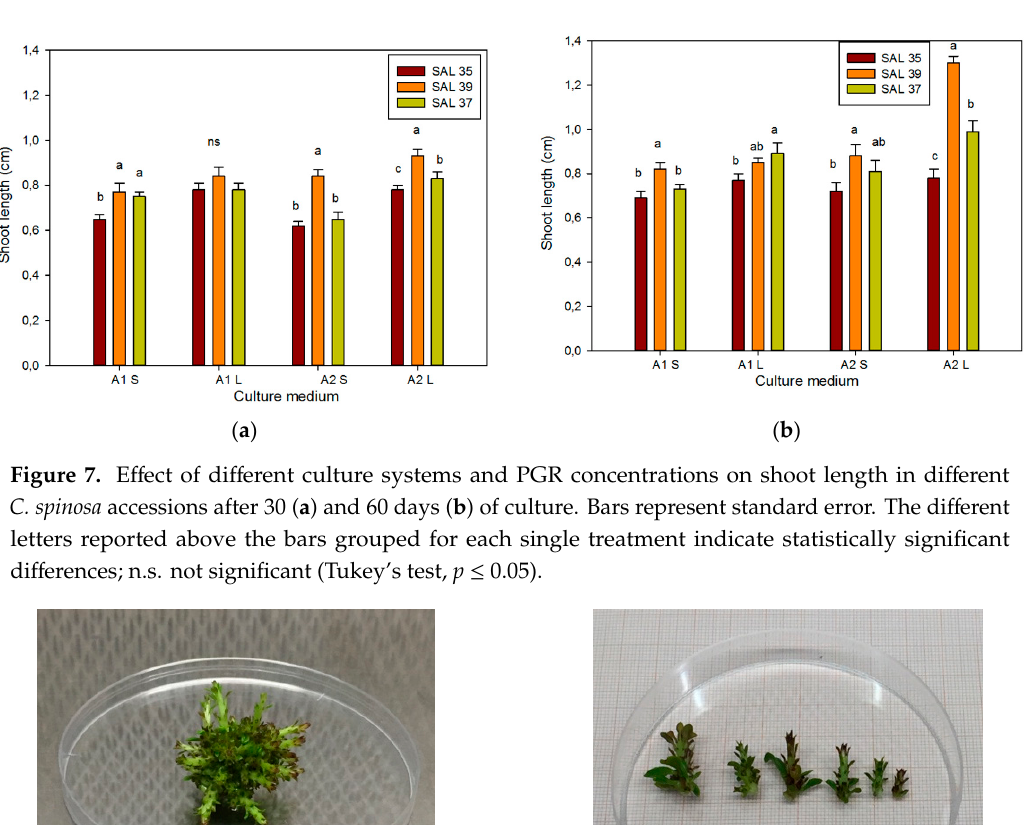
Plants 2019 , 8 , x